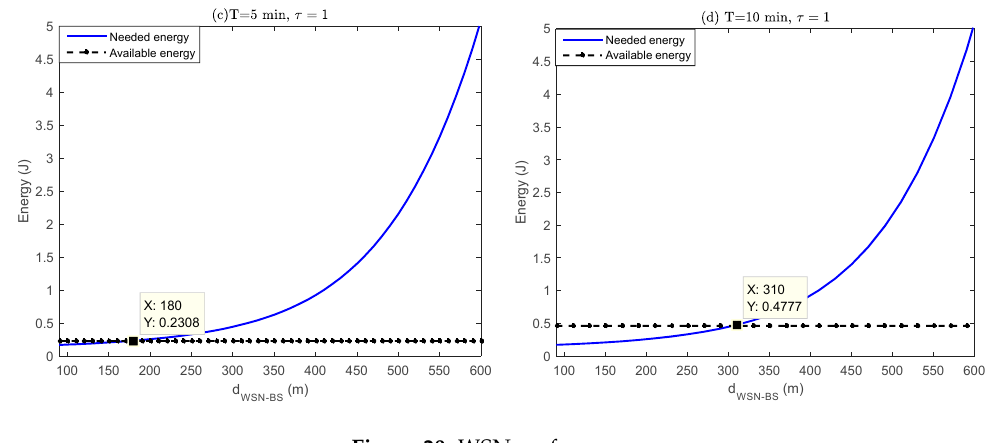
Figure 20. WSN performance.